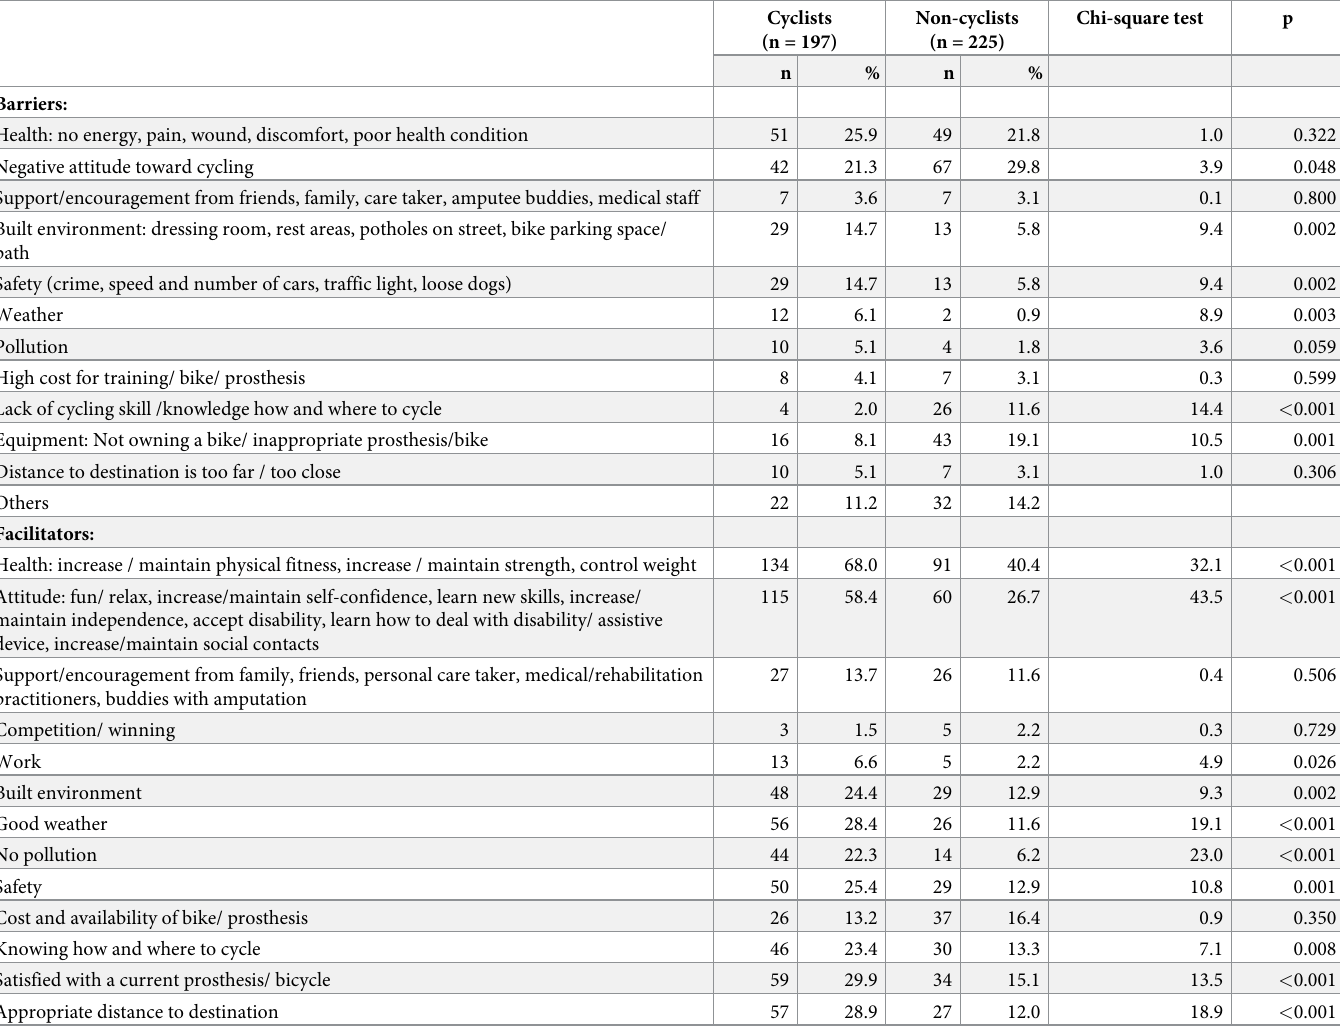
Table 6. Cycling barriers and facilitators of cyclists and